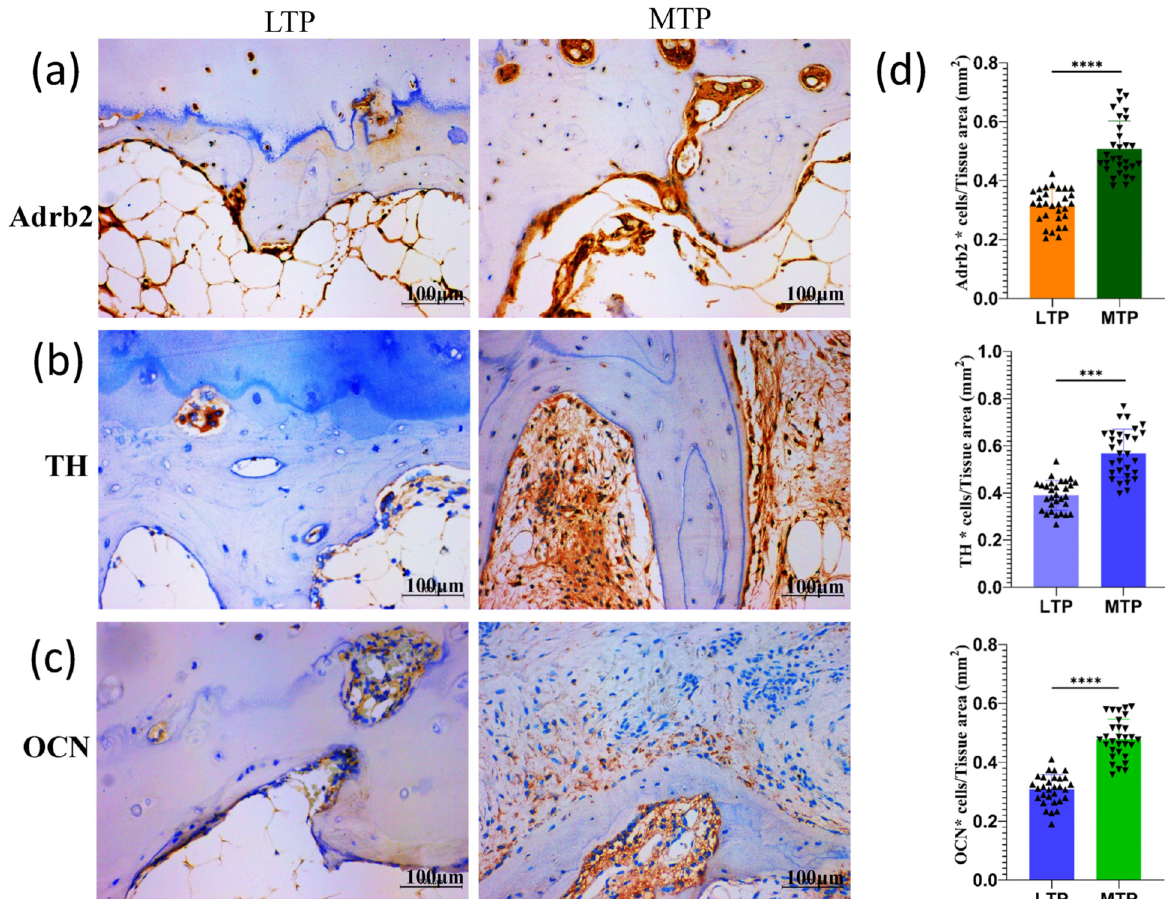
Figure 4: Immunohistochemistry analysis of Adrb2, TH and OCN expression in subchondral bone of LTP and MTP ( a – c ) Representative images of Adrb2, TH, and OCN expression in the subchondral bone of LTP and MTP. ( d ) Bar graphs show semiquantitative evaluation of Adrb2, TH, and OCN immunohistochemistry. Magni fi cation × 200, scale bar 100 µm; *** P < 0.001, **** P <